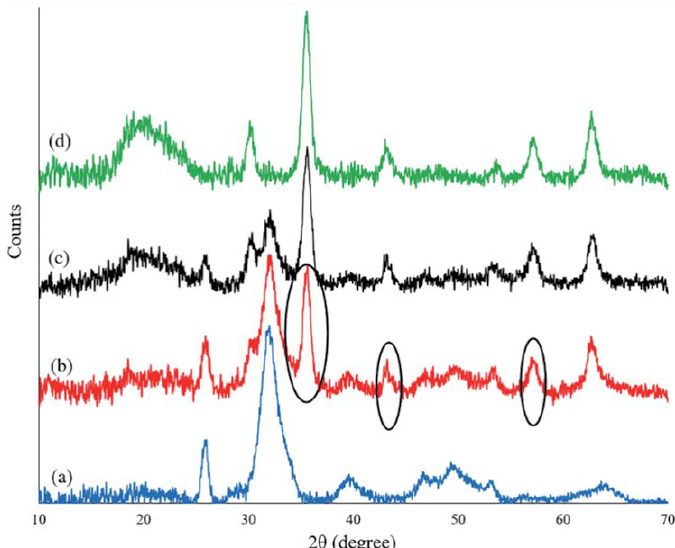
Fig. 7. XRD patterns of adsorbent (a) FS, (b) after nanoparticle impregnation (MFS), (c) after the adsorption of MB (UMFS), (d) after the regeneration process (RMFS).